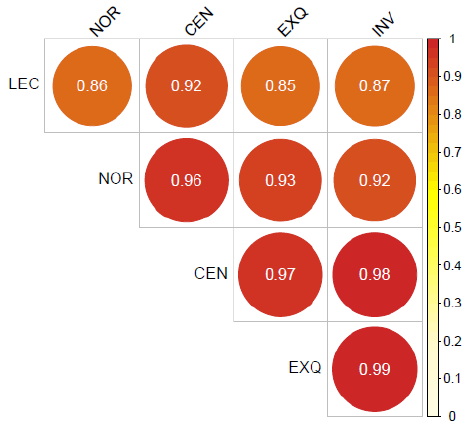
Figure 2. Correlation matrix between different methods. The r coefficients show that LEC purification performed slightly different than the other methods. All the correlations are highly significant ( p < 0.001).